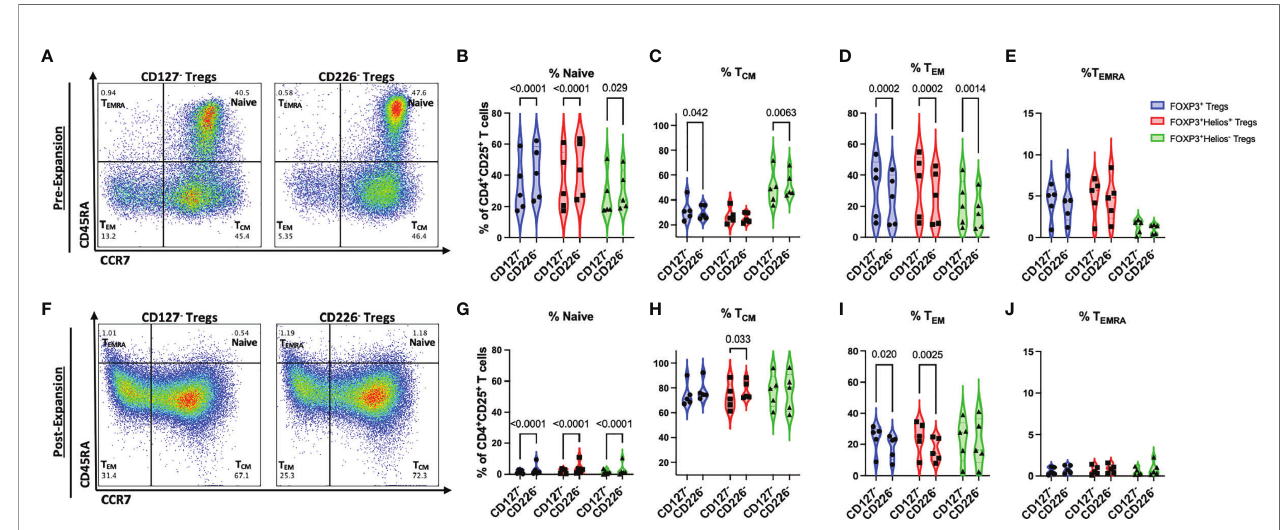
FIGURE 4 | CD226 - Tregs display a more immunoregulatory phenotype than CD127 lo/- Tregs. Memory differentiation of Tregs from each FACS method was assessed by CD45RA and CD197 (CCR7) expression (A – E) at day 0 following isolation and (F – J) at day 14 following ex vivo expansion ( n = 5 biological with n = 2 technical replicates). (A, F) Representative fl ow plots pre-gated on live CD4 + CD25 + cells show percentages for each T cell memory subset for CD127 lo/- sorted Tregs and CD226 - sorted Tregs. Relative proportions of (B, G) CD45RA + CCR7 + naïve, (C, H) CD45RA - CCR7 + T CM , (D, I) CD45RA - CCR7 - T EM , and (E, J) CD45RA + CCR7 - T EMRA subsets from CD127 lo/- sorted Treg and CD226 - sorted Treg cultures after gating on CD4 + CD25 + FOXP3 + Tregs (blue), CD4 + CD25 + FOXP3 + Helios + Tregs (red), and CD4 + CD25 + FOXP3 + Helios - Tregs (green). P-values are reported on the fi gure for two-way ANOVA with Bonferroni post- hoc correction for multiple comparisons of Treg isolation conditions from matched